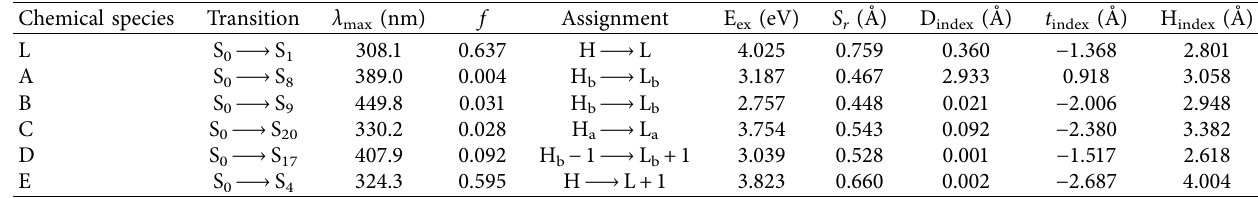
Table 8: Absorption spectra data obtained by TD-DFT methods for studied compounds at PBE0/D3BJ/ma-def2-TZVP/def2/J level in the gas phase. Chemical